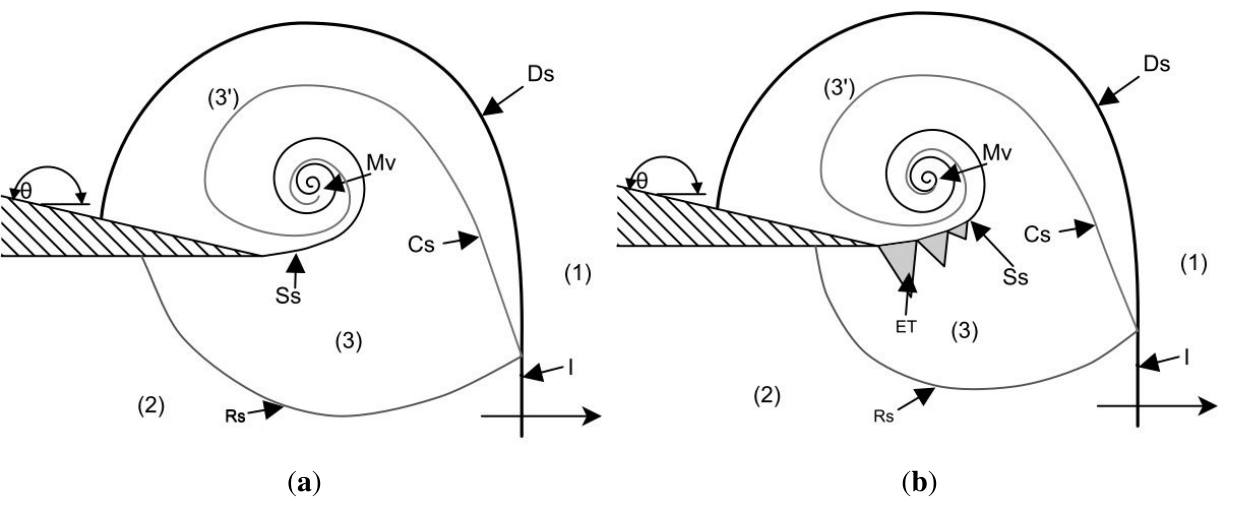
Figure 2. Basic flow structure behind a shock wave diffracting around a sharp